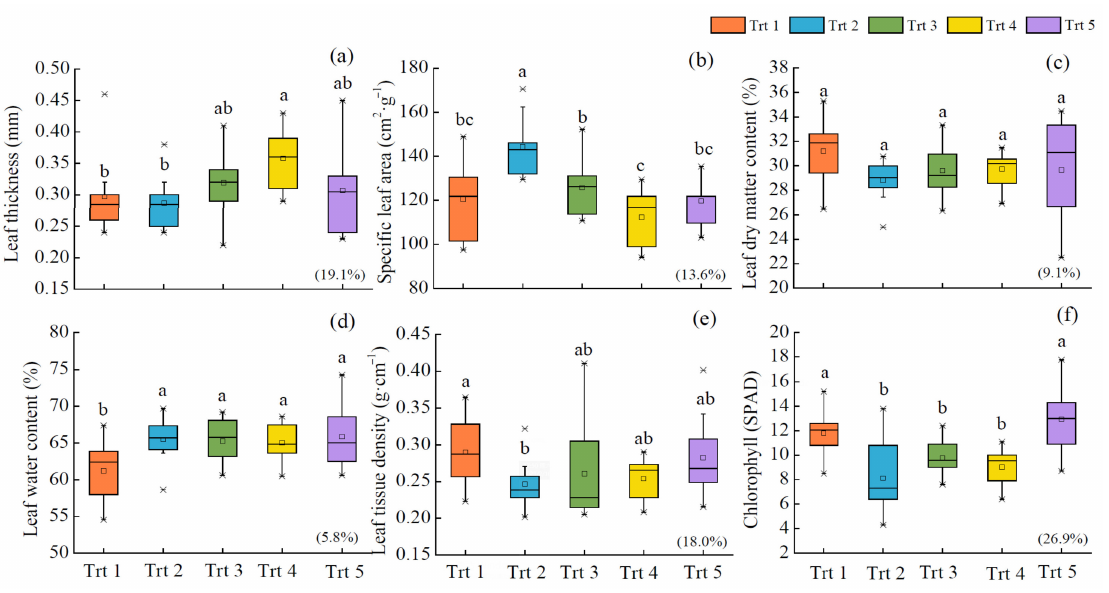
Figure 2. Leaf thickness ( a ), specific leaf area ( b ), leaf dry matter content ( c ), leaf water content ( d ), leaf tissue density ( e ) and chlorophyll ( f ) of Z. planispinum in different planting combinations. Trts 1–5, five plantations, representing the research objects of this article. Bars show mean ± standard deviation, n = 30. “ (cid:3) ” in the box plot indicates the mean value of individual plant traits; different lowercase letters indicate significant differences between trait values ( p < 0.05); percentages in parentheses are the CV. Table 4. Carbon, nitrogen, and phosphorus contents and stoichiometric ratios of Z. planispinum